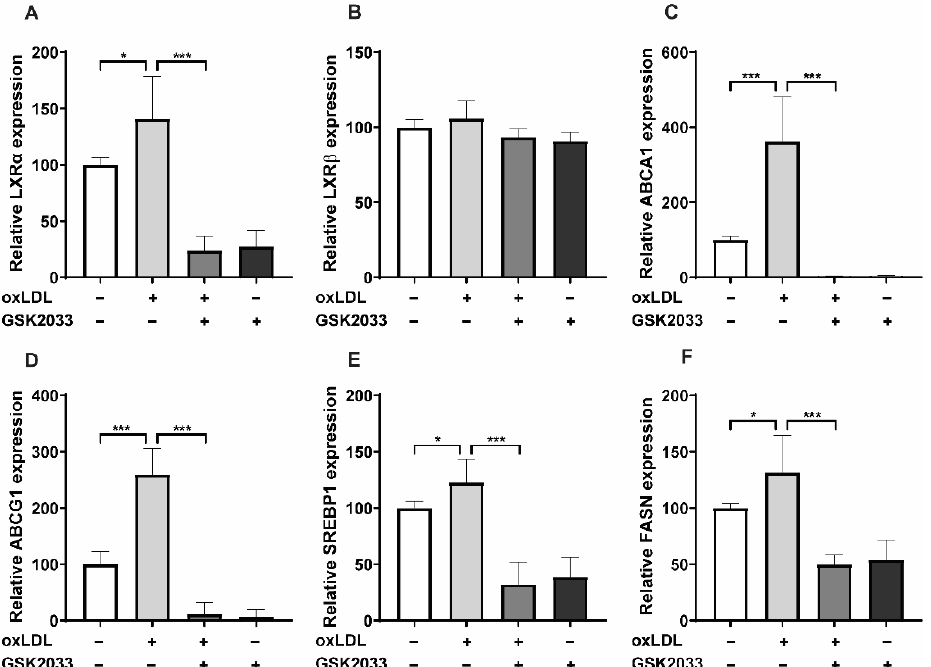
Figure 4. GSK2033 inhibits oxLDL induced upregulation of LXR target genes. Monocytes were treated as indicated with 20 µg/mL oxLDL, 2.5 µM GSK2033 (LXR antagonist), or vehicle for 24 h and lysed for RNA expression. mRNA levels of LXRα , LXRβ , ABCA1 , ABCG1 , SREBP1 and FASN were analyzed by real-time qPCR ( A – F ). Graphs represent mean values ± SD of six individuals in three different experiments. * p < 0.05 and *** p < 0.001.